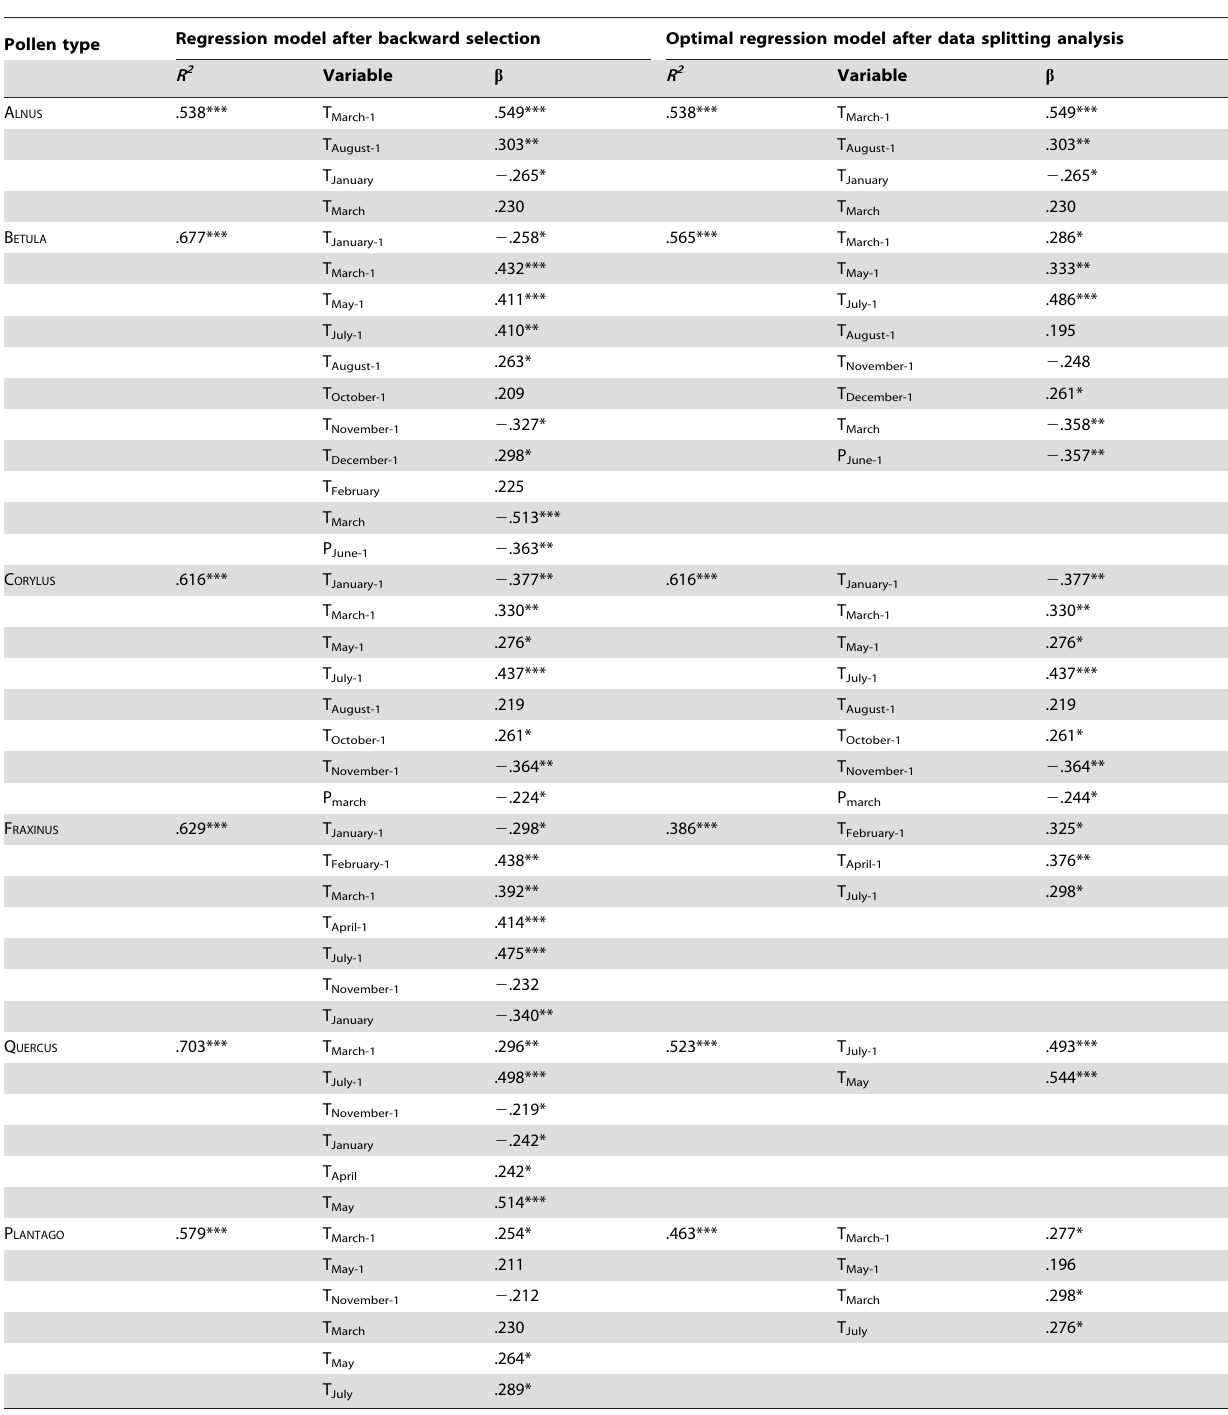
Table 7. Statistical parameter values of the regression model with backward selection method and the optimal regression model after data